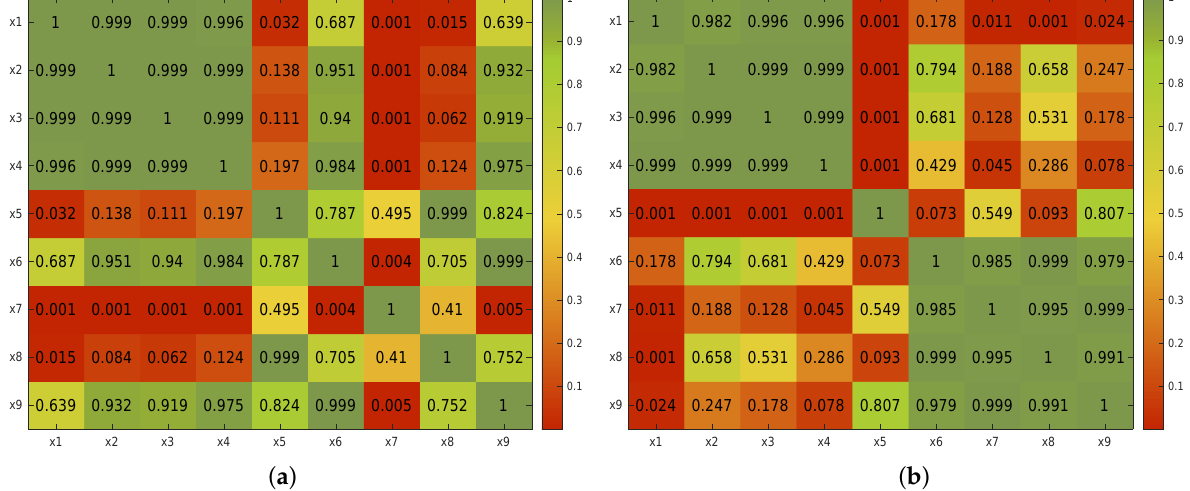
Figure 4. Temporal region. Comparisons of p -values obtained with ANOVA by pairs. ( a ) N100 amplitude. ( b ) P200